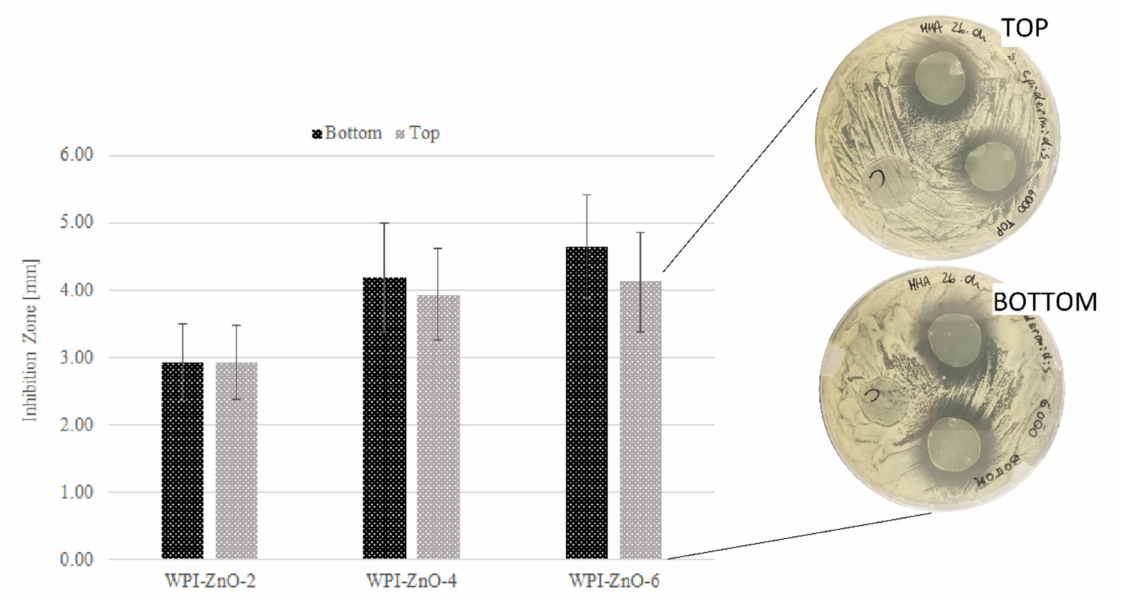
Figure 12. Effect on the inhibitory activity of WPI–ZnO films of top and bottom faces against S. epidermidis